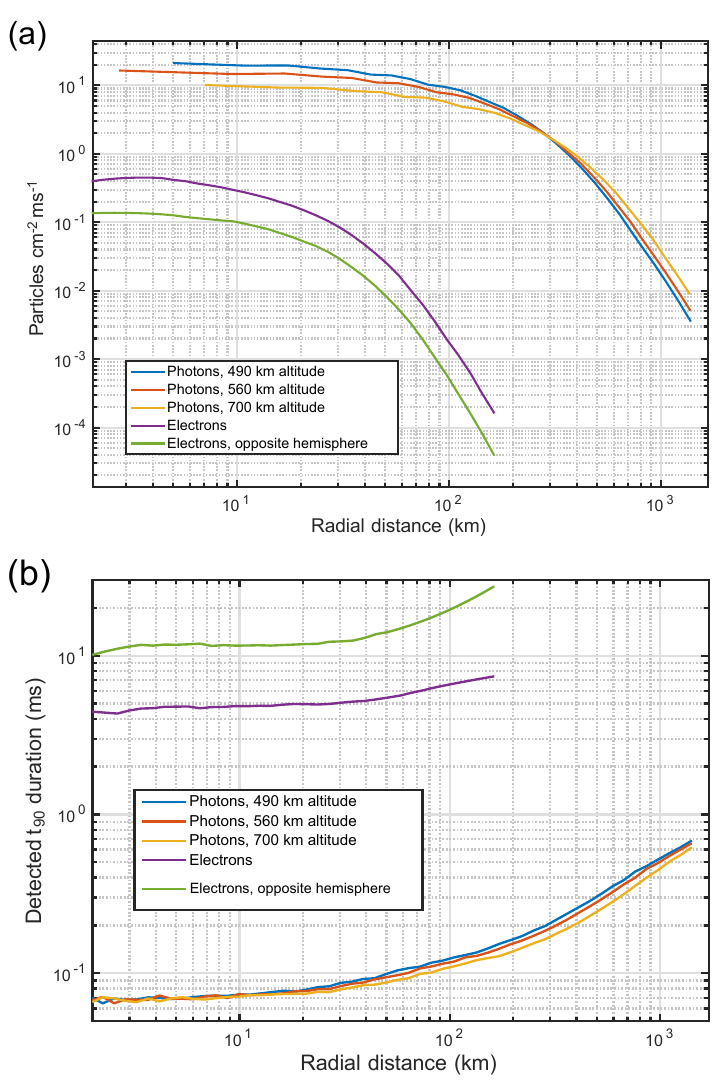
Figure 3. Results of MC-PEPTITA simulations. (a) Flux profile vs. radial distance between the TGF source (projection at satellite altitude) and the satellite for photons (various altitudes) and electrons (seen at the hemisphere of production and in the opposed hemisphere). The two electron profiles correspond to a detection altitude of 560km, but are very close for 490 or 700km altitude. (b) t 90 durations associated to the flux profiles. Like for the flux profiles, the electron distributions stay very similar at 490 or 700km altitude. Table 2. Altitudes, detection count thresholds, limit radii, detection efficiencies and number of TGFs per year (observed and estimated) for the considered